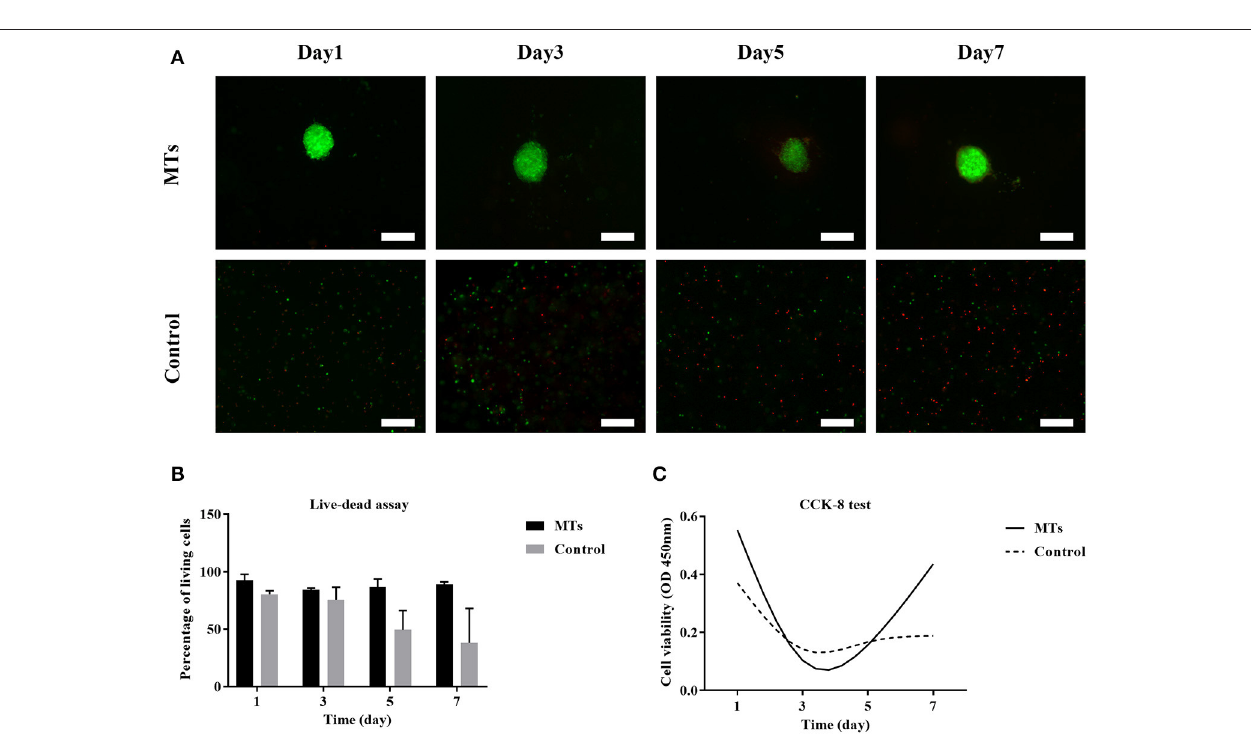
FIGURE 8 | Live-dead assay of MTs and the control group bioprinted in the 3D structure (A) . Fluorescence image showed live cells (green) and dead cells (red), inset bar = 100 µ m. The quantitative data of cell viability at different time points in the bioprinted 3D structure (B) . CCK-8 test to detect the proliferation of MTs and the control group in the bioprinted 3D structure (C)